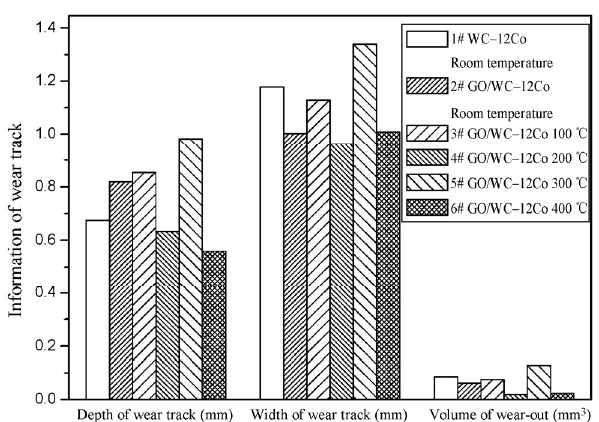
Fig. 11 Wear track properties for GO/WC–12Co after undergoing high-temperature wear.